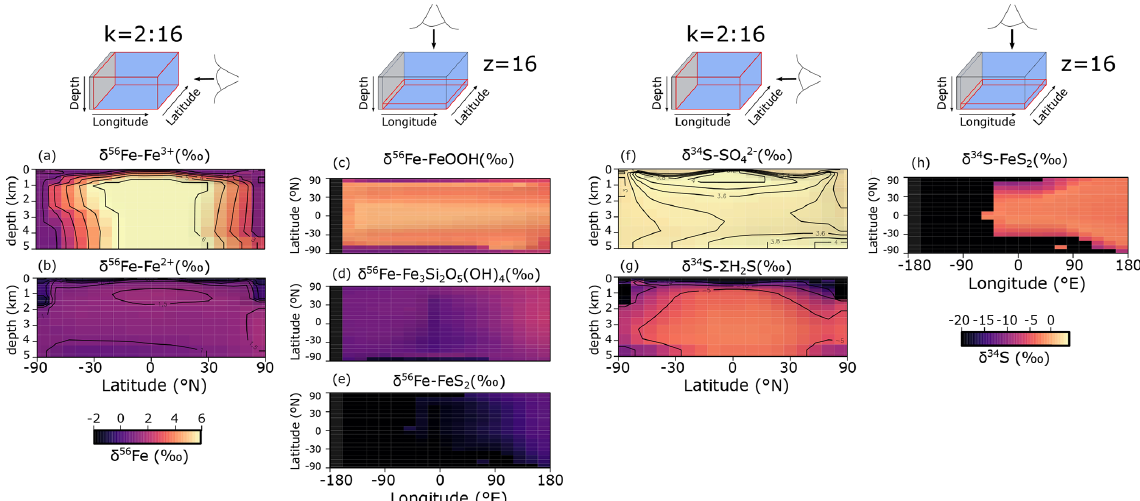
Figure 9. (a–e) Modelled stable Fe isotope signatures of key dissolved and solid-phase Fe species. Shown are zonally averaged values for (a) dissolved ferric Fe ( δ 56 Fe − Fe 3 + ) and (b) dissolved ferrous iron ( δ 56 Fe − Fe 2 + ), as well as the isotope compositions at the seafloor of (c) iron oxides ( δ 56 Fe − FeOOH), (d) greenalite ( δ 56 Fe − Fe 3 Si 2 O 5 ( OH ) 4 ), and (e) pyrite ( δ 56 Fe − FeS 2 ) for an ocean with 50% of the modern phosphate inventory. All values are in per mille relative to IRMM-14. (f–g) Modelled stable S isotope signatures of key dissolved and solid-phase S species. Shown are zonally averaged values for (f) sulfate ( δ 34 S − SO 2 − ) and (g) dissolved free sulfide ( δ 34 S − (cid:54) H 2 S), as 4 well as (h) the isotope composition at the seafloor of pyrite ( δ 34 S − FeS 2 ). All values are in per mille relative to VCDT.